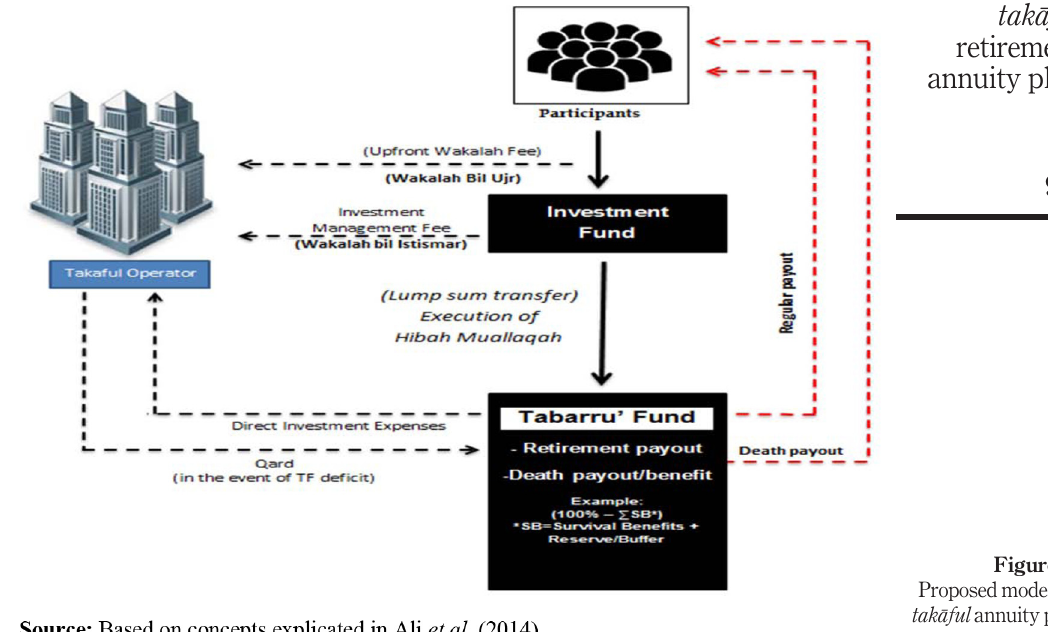
Figure 1. Proposed model